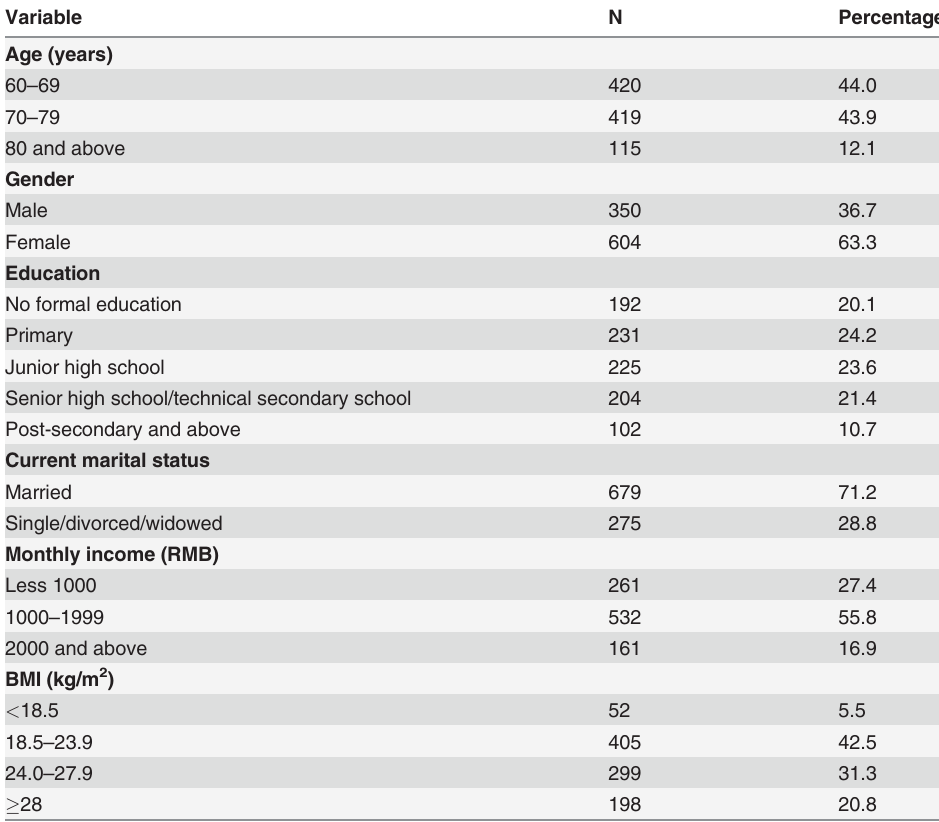
Table 1. Demographic characteristics of the sample (n =